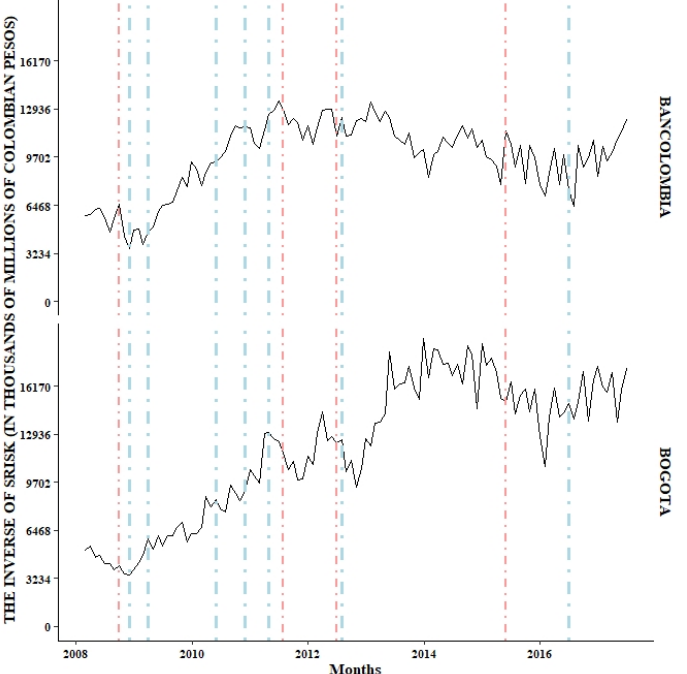
Figure 3. Monthly behavior of the SRISK systemic risk measure for BANCOLOMBIA and BOGOTÁ banks. Source: owner .